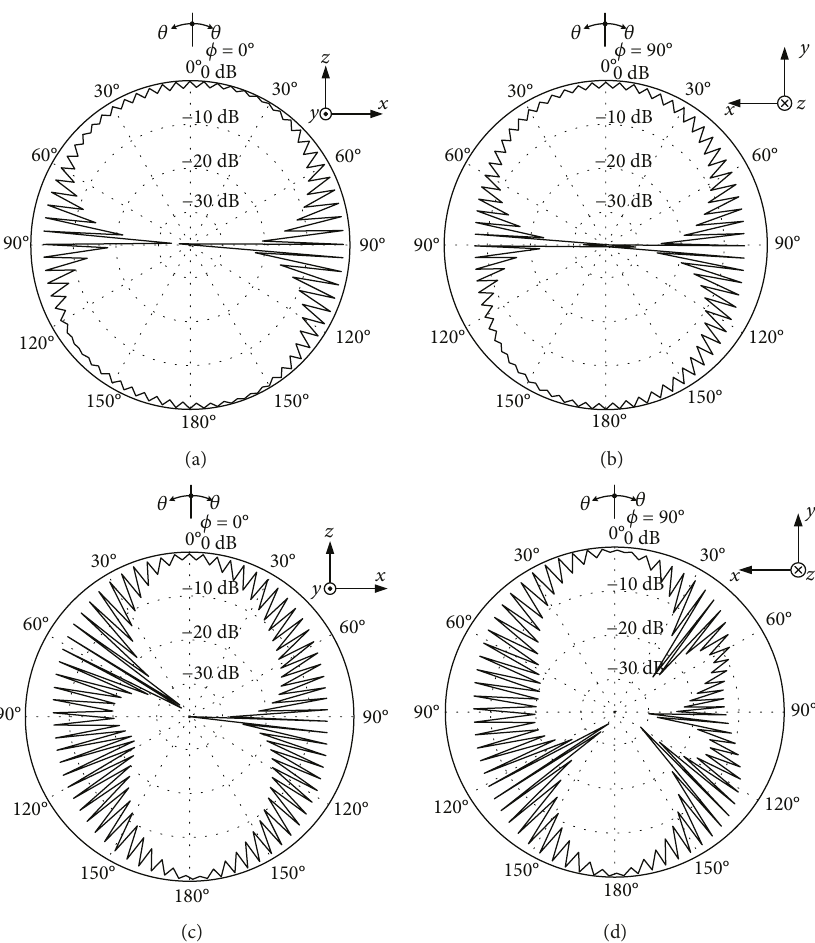
Figure 12: The simulated axial ratio radiation patterns: (a) 2.45GHz at ϕ =0 ° , (b) 2.45 GHz at ϕ =90 ° , (c) 5.8GHz at ϕ =0 ° , (d) and 5.8GHz at ϕ =90 °